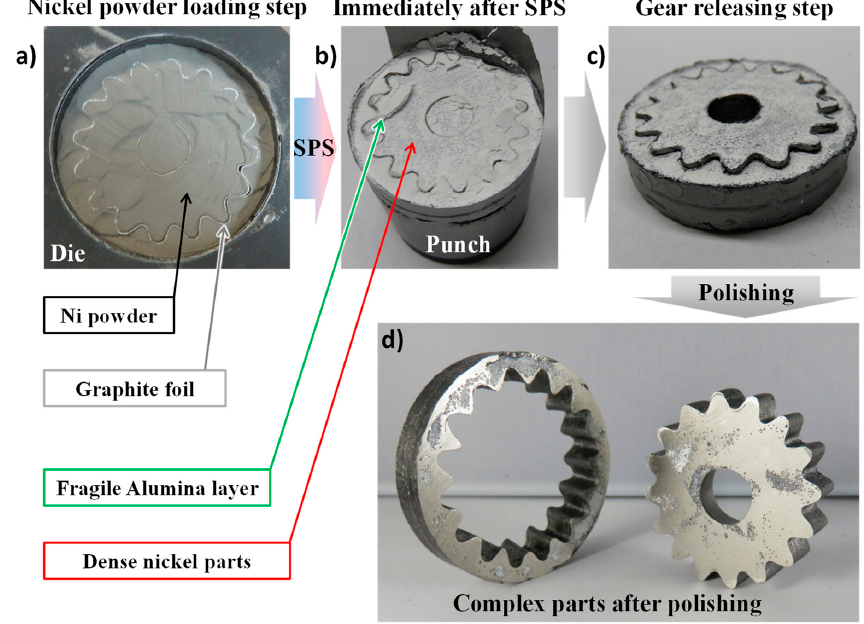
Figure 6. Photos of the main steps of the spark plasma sintering (SPS) experiment, from the powder loading to the obtained complex shapes; ( a ) loading; ( b ) after SPS; ( c ) releasing; and ( d ) the parts after polishing.